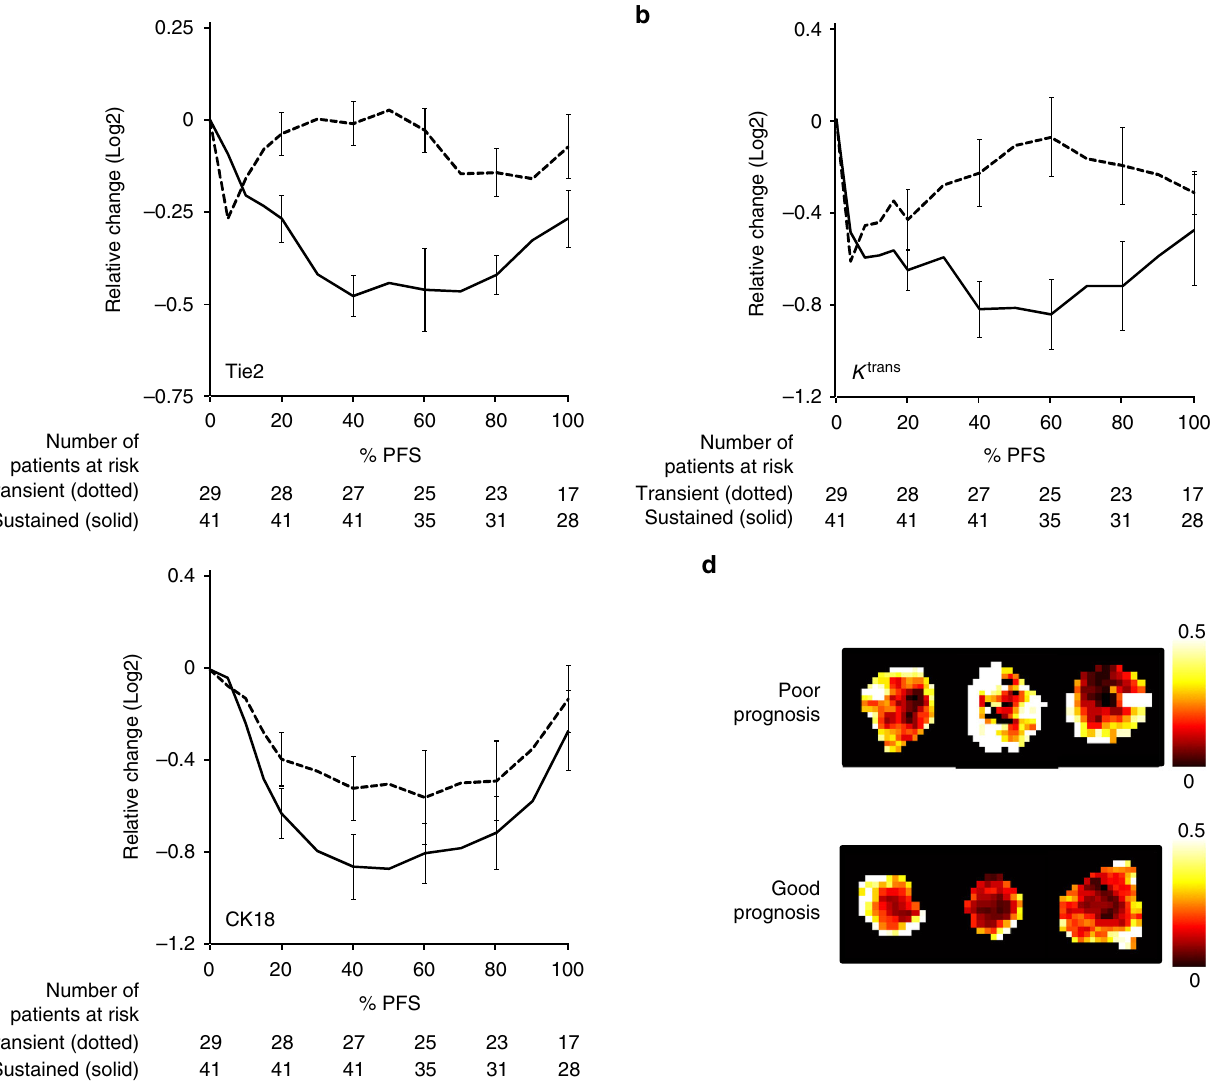
Fig. 3 Changes in Tie2 but not CK18 re fl ect tumor vascular control ( K trans ). Two cohorts (or clusters) of patients were identi fi ed through an unsupervised hierarchical clustering of Tie2 trajectories ( a ). In one cohort, there was an immediate but transient reduction (dotted line) in Tie2, while in the other cohort there was a later but more sustained reduction (solid line). The two cohorts behaved signi fi cantly differently ( P = 1.8 × 10 − 6 , Mann – Whitney U test). Similar cohorts of patients were identi fi ed with K trans values ( b ), which again behaved signi fi cantly differently ( P = 0.003, Mann – Whitney U test). The pattern of behavior of CK18 was different ( c ), and the two cohorts were not signi fi cantly different ( P = 0.18, Mann – Whitney U test). This indicates that Tie2 re fl ects the impact of bevacizumab on tumor vasculature. Error bars indicate the standard error. d Shows an example of K trans parameter maps, which re fl ect the tumor behavior of the two cohorts, shown in b . The largest difference in parameter maps can be seen in the two middle position maps, which correspond to the maximum difference between the two cluster-derived curves. CK18; cytokeratin 18, K trans ; endothelial transfer